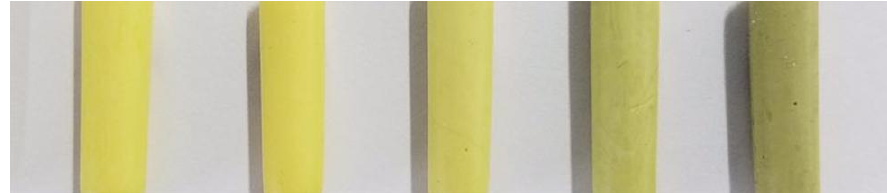
Figure 4. Appearances of polyimide (PI) aerogels with different A-AgNWs contents. From left to right PI-0, PI-0.1, PI-0.2, PI-0.5, PI-2.